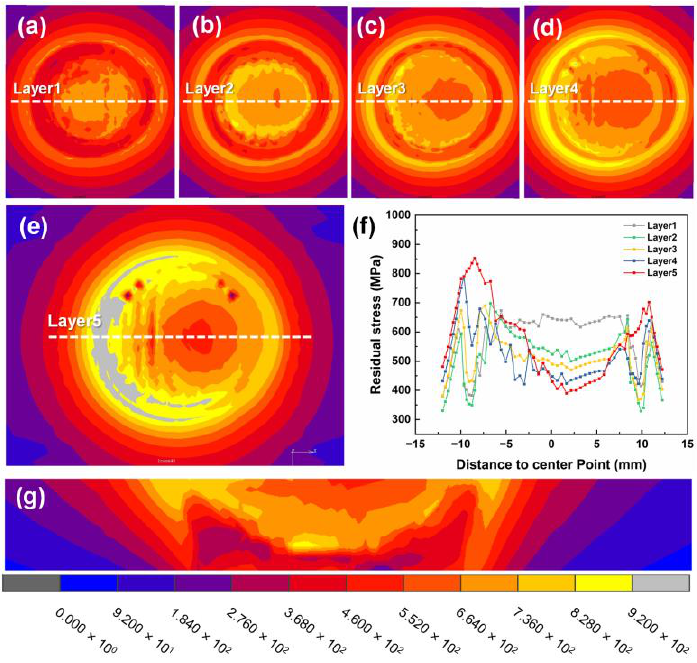
Figure 9. Comparison between numerical and experimental deformations.